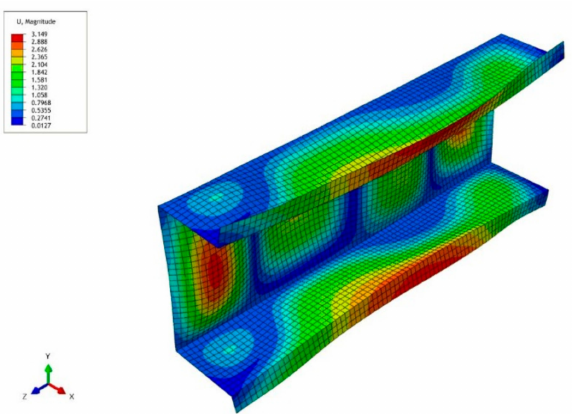
Figure 18. Collapse mode at the point of the ultimate load-carrying capacity for the TH-channel of total length 225